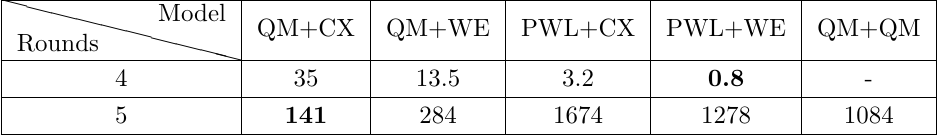
Table 5: Solving times for ARIA over 4 and 5 rounds depending on the modeling. Timings are given in seconds, for the full solve for 4 rounds and over a subset of all cases for 5